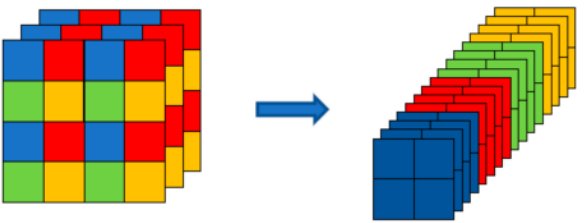
Figure 7. Focus Module. A 4 × 4 input image is divided into four 2 × 2 slices and the pixels in the same slice have a similar relative position in the input